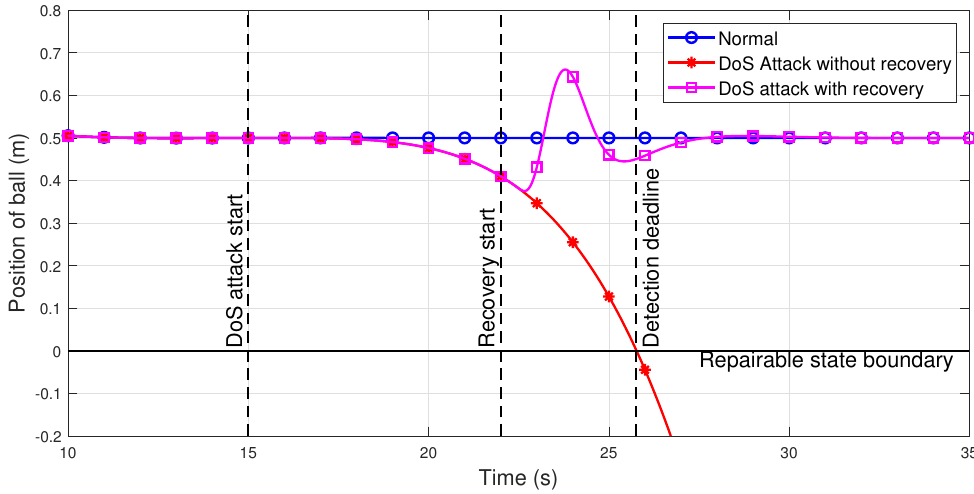
Figure 7. Real-time attack detection and